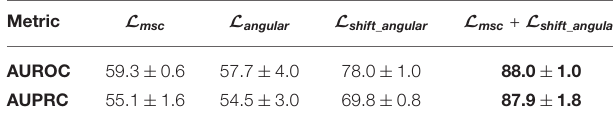
TABLE 3 | Training objective ablation study (AUROC% and AUPRC%).